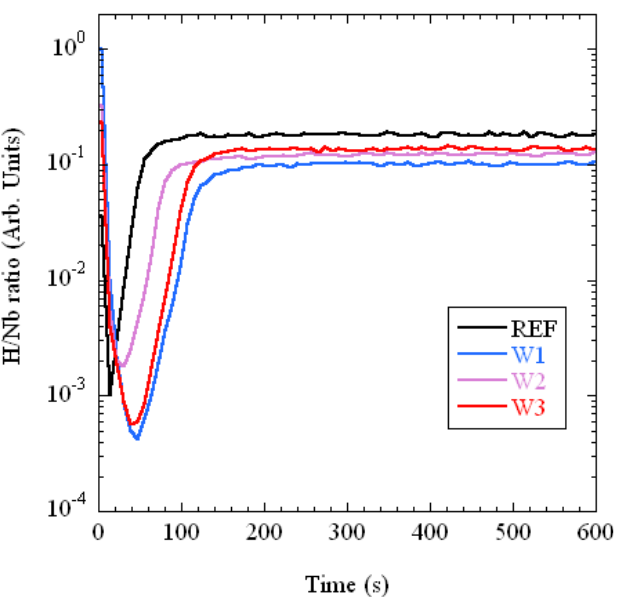
FIG. 14. (Color) SIMS depth profile of the total oxygen content normalized to the Nb peak done at Jefferson Lab for two large- grain samples, unbaked as reference and baked in air at 120 (cid:3) C for 3